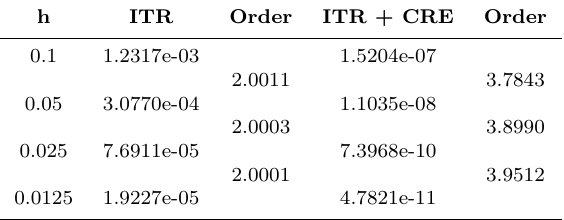
Table 3. Global errors at T = 1 in absolute value in Example (4.3) obtained by the implicit Trapezoidal (ITR) method as underlying method and reducing h by a factor of 2. h ITR Order ITR + CRE